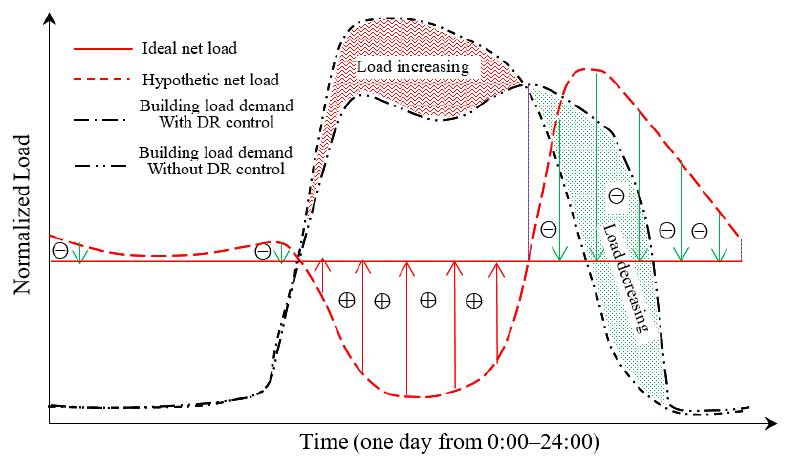
Figure 3. Schematic diagram of energy flexibility in buildings.